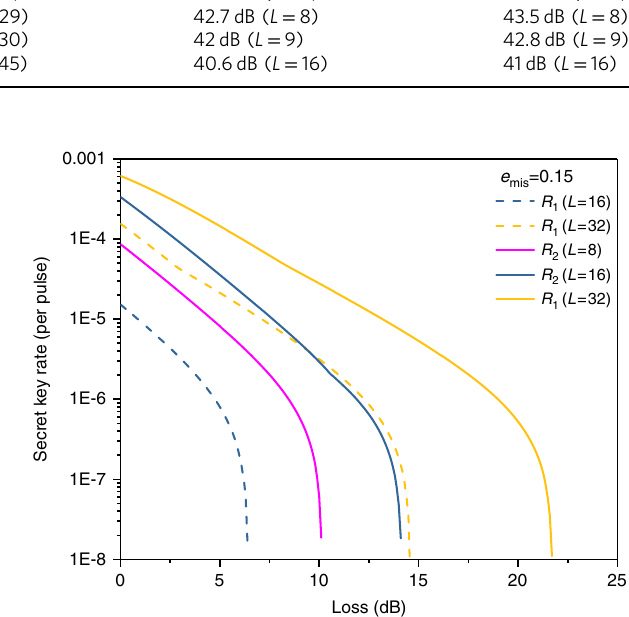
Fig. 1 Secret key rate R versus channel loss. R 1 and R 2 represent the original RRDPS protocol and the proposed one, respectively. R (BB84) is for the BB84 protocol with in fi nite decoy states. Both R 1 and R 2 are simulated for the scenarios without monitoring signal disturbance